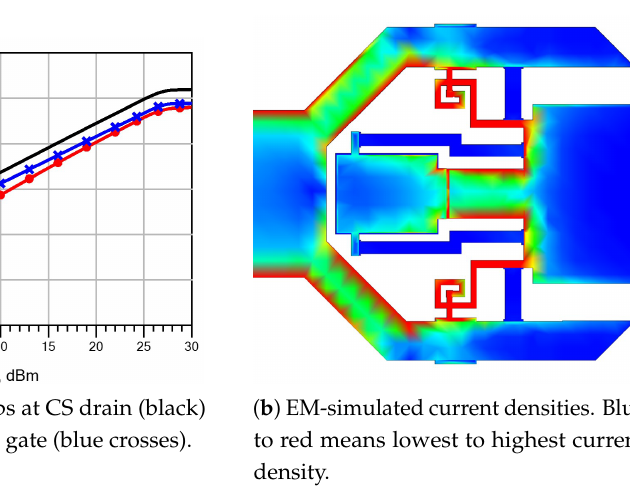
Figure 23. Power split between gate and source in the L GS cell.